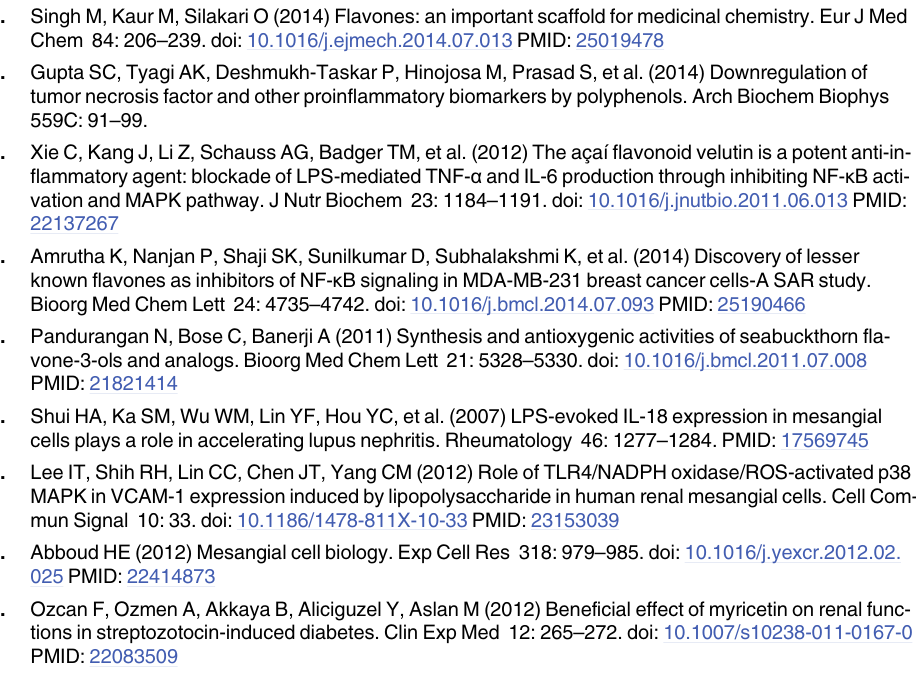
of compounds on the 50